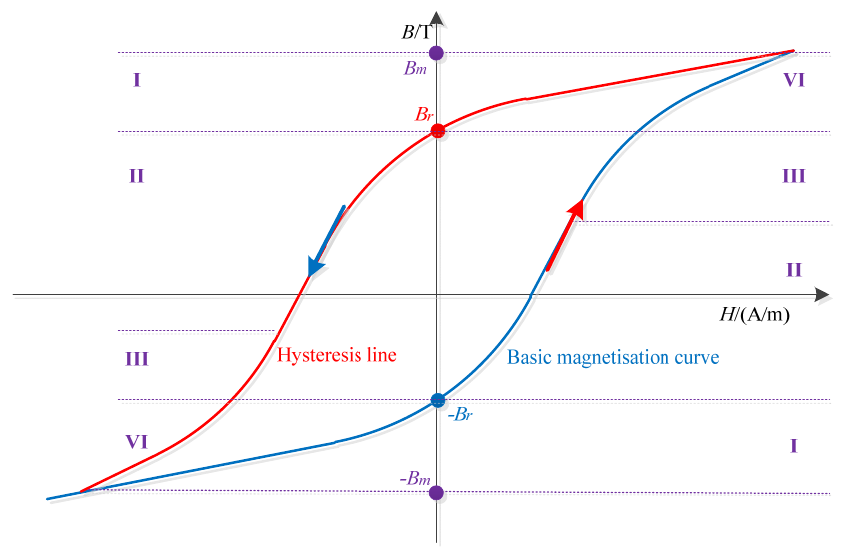
Figure 1. Transformer core magnetization curve partition diagram.